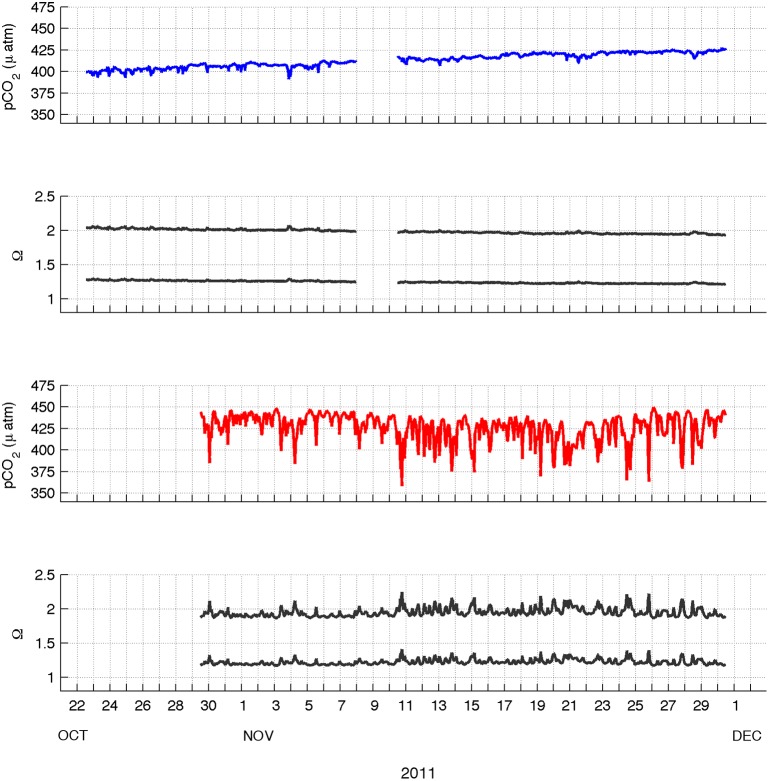
Estimated pCO2 and carbonate ion saturation states (Ω) based on observed pH and estimated alkalinity.Data in the upper two panels refer to Hut Point while the two lower panels refer to Cape Evans. Lines in pCO2 panels are color coded by location (Hut Point, blue; Cape Evans, red) while lines in carbonate saturation panels indicate Ωcalcite (upper black line in panel) and Ωaragonite (lower black line in panel). Alkalinity estimates were location-specific and based on temperature and salinity measurements using the method of [52].